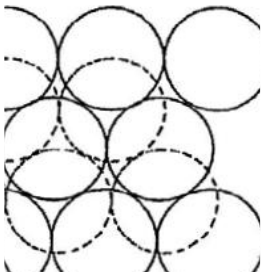
Figure 1. Contact configuration of spheres in hexagonal